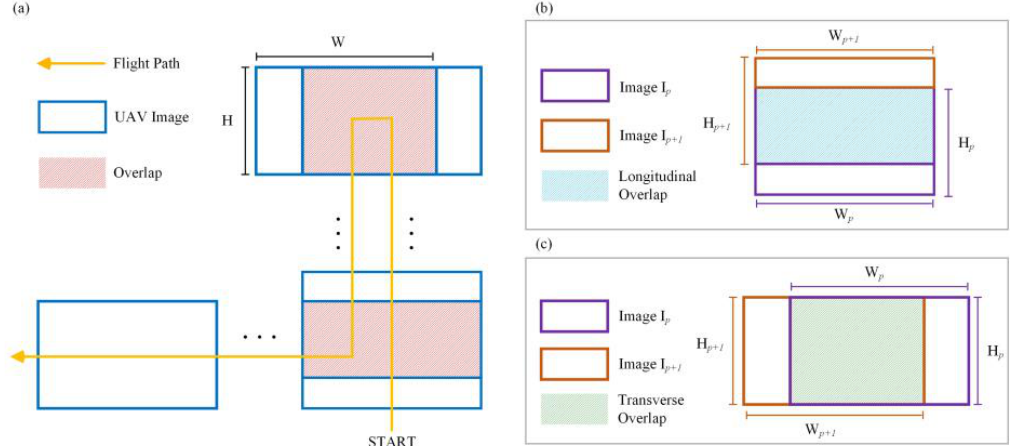
Figure 2. Schematic diagram for an unmanned aerial vehicle (UAV) capturing images in crop growth monitoring. In ( a ), the orange line represents the flight trajectory of the UAV; the blue rectangles represent the captured UAV images; and the shading in the blue rectangles represents the overlap of images. ( b ) represents the transverse overlap with 70% and ( c ) represents the longitudinal overlap with